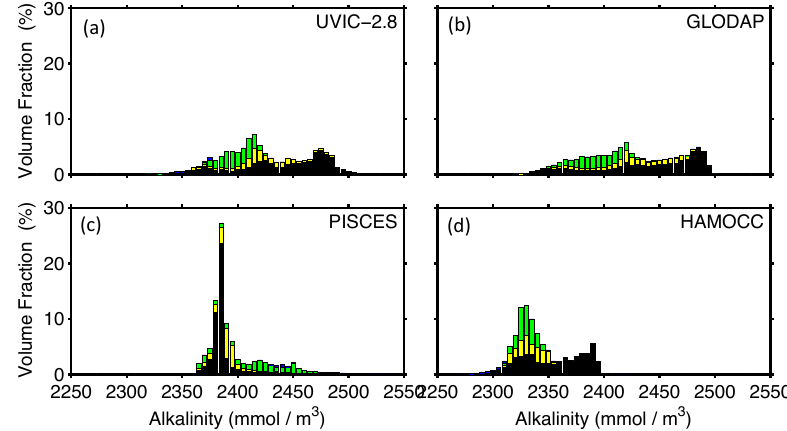
Figure 5. Global ocean volume-weighted frequency-distribution of alkalinity in observations (GLODAP data set, Key et al., 2004) and three global carbon cycle models (see Duteil et al., 2012 for details). Fractions of the Atlantic, Pacific, Indian and Arctic Oceans are indicated by colour codes (green, black, yellow and blue,